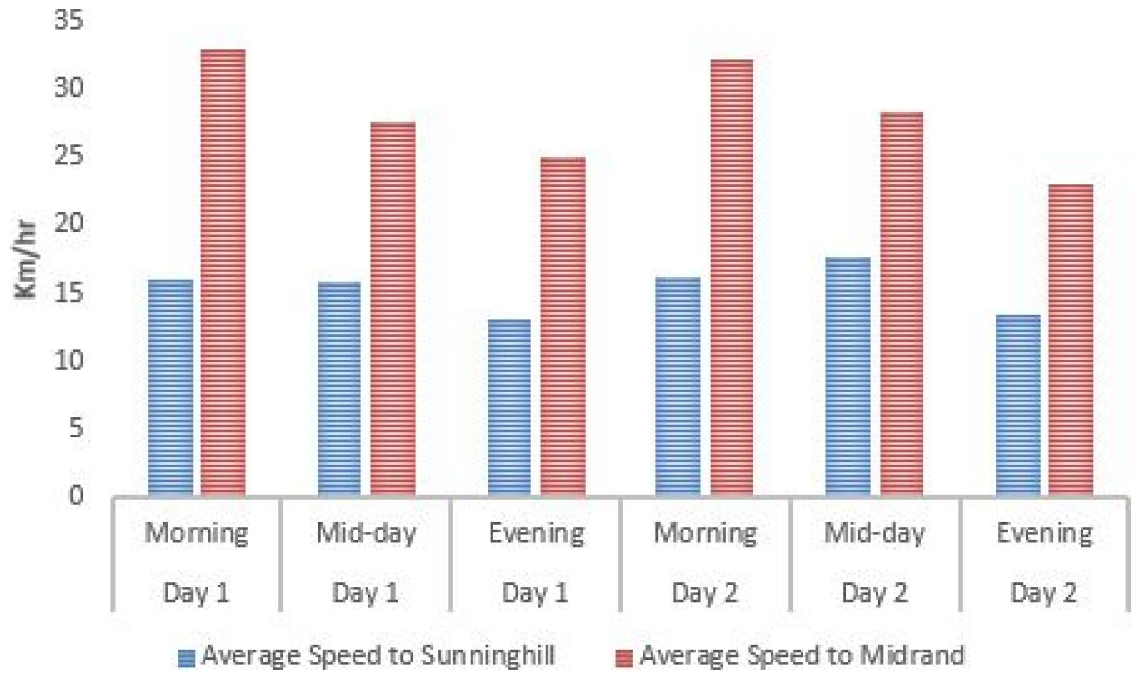
Fig 11. Average travel speed on the M3 Gaubus route near Midrand Gautrain station.